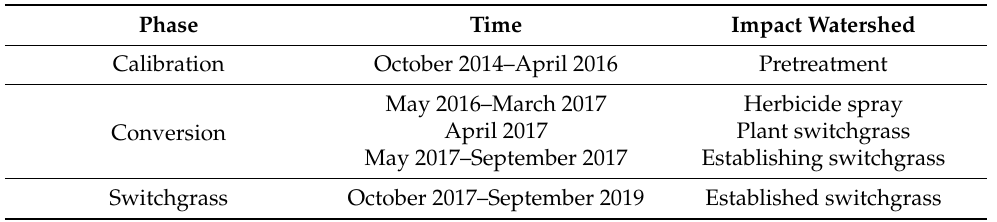
Table 1. Timeline of treatments for the Impact Watershed from water years 2015 through 2019. The three major phases were: calibration; conversion (disturbance and establishment); and switchgrass (established